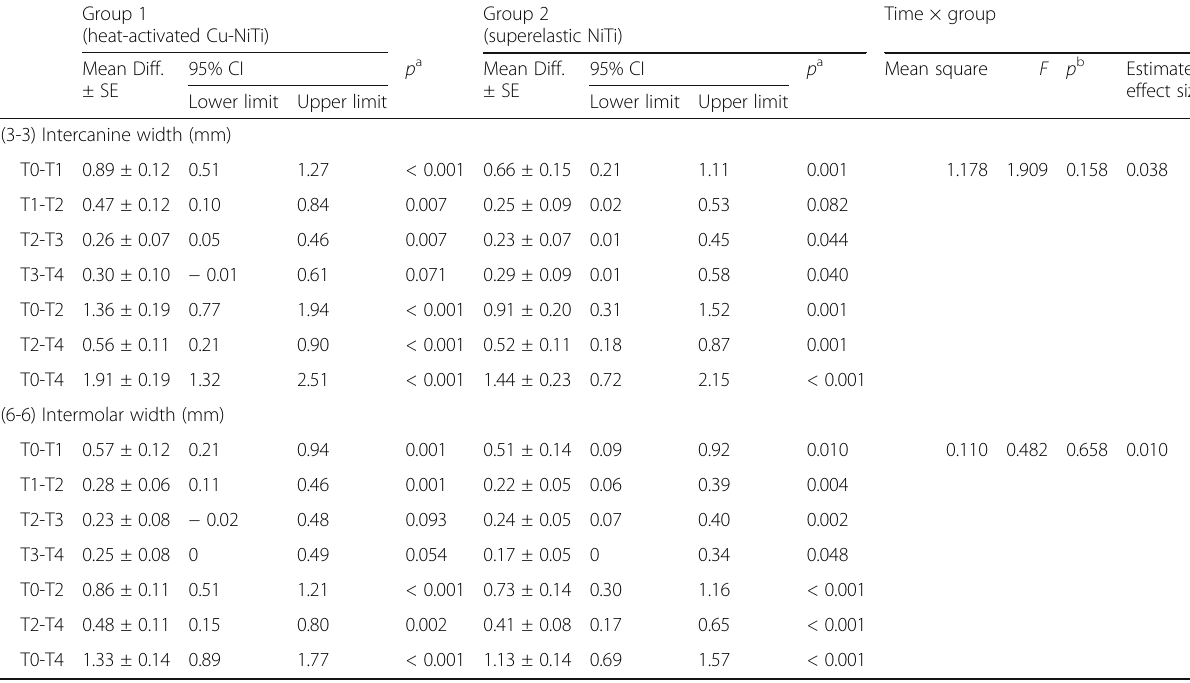
Table 3 Comparison of intercanine and intermolar changes between and within the groups Group 1 (heat-activated